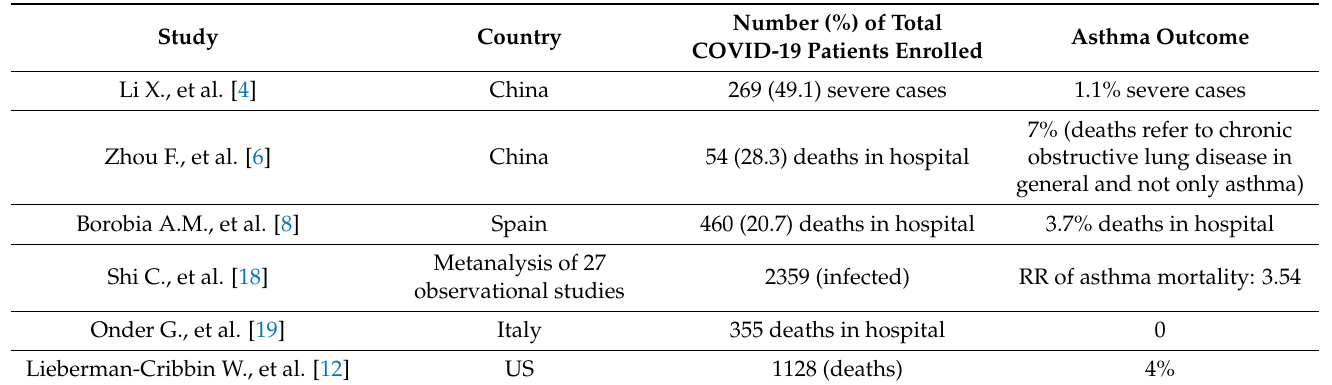
Table 2. Asthma and COVID-19 severity/mortality